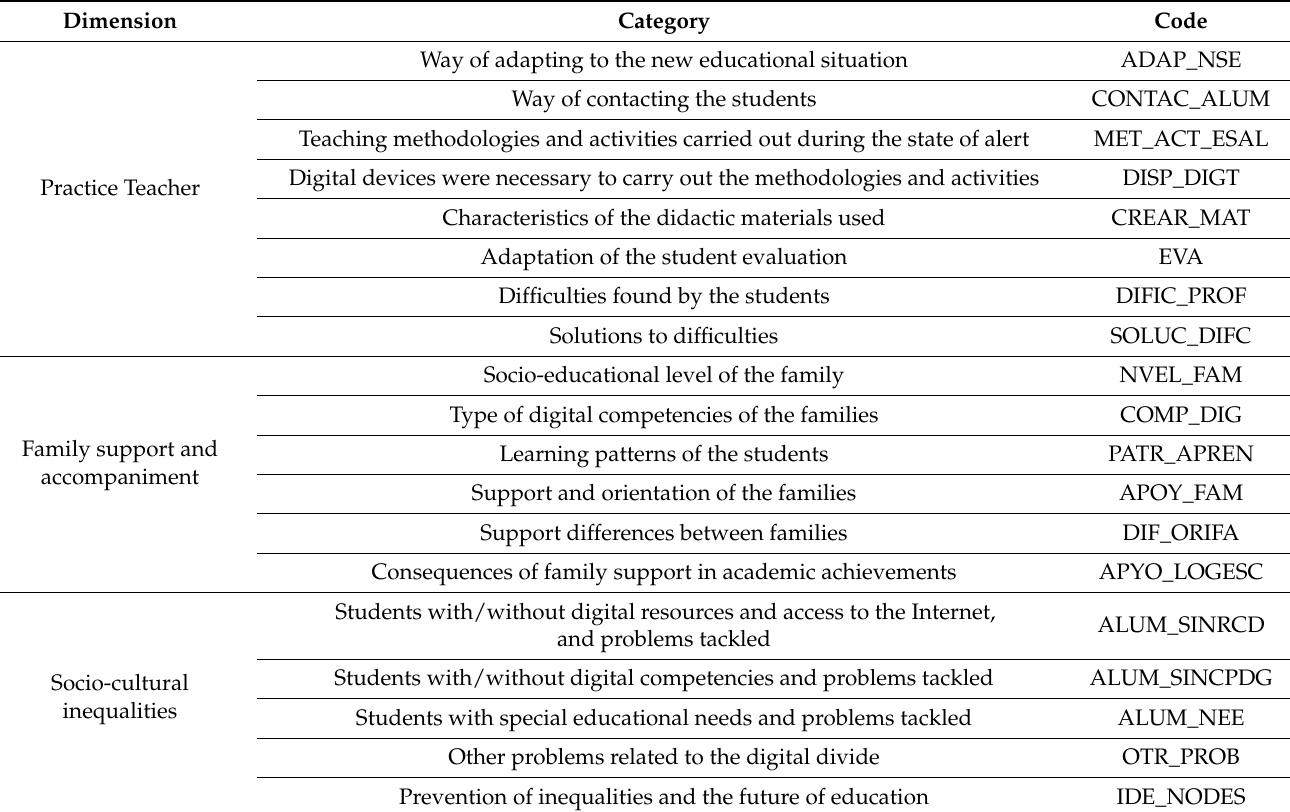
Table 1. System of emergent dimensions, categories and